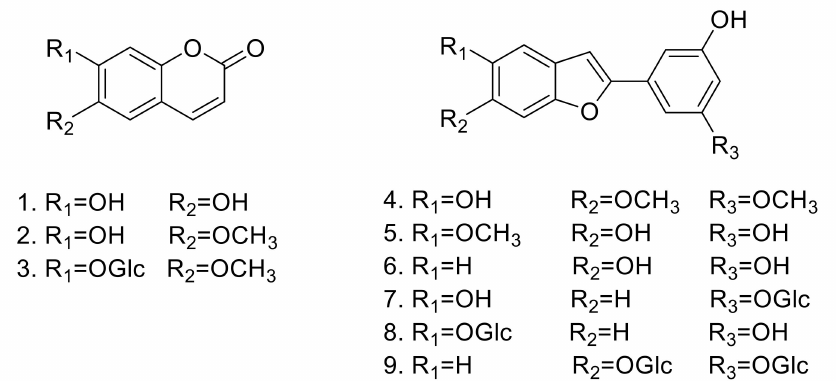
Figure 1. Structures of compounds 1 – 9 isolated from M. alba